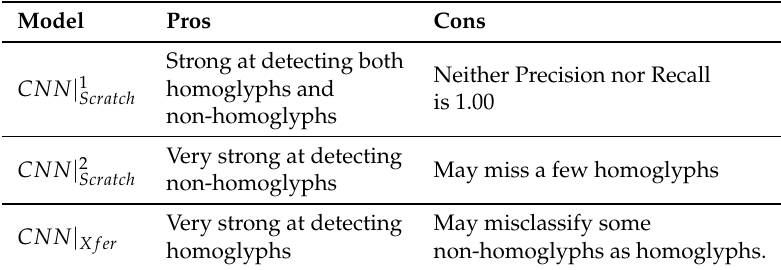
Table 3. Verdict on the three models.